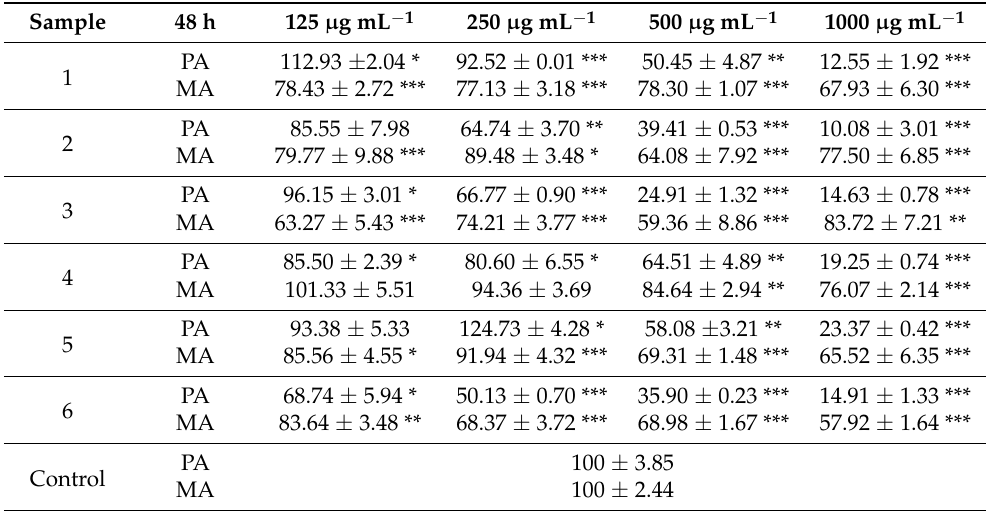
Table 5. Values of proliferative and metabolic activity (%) of VERO cells after 48 h of exposure